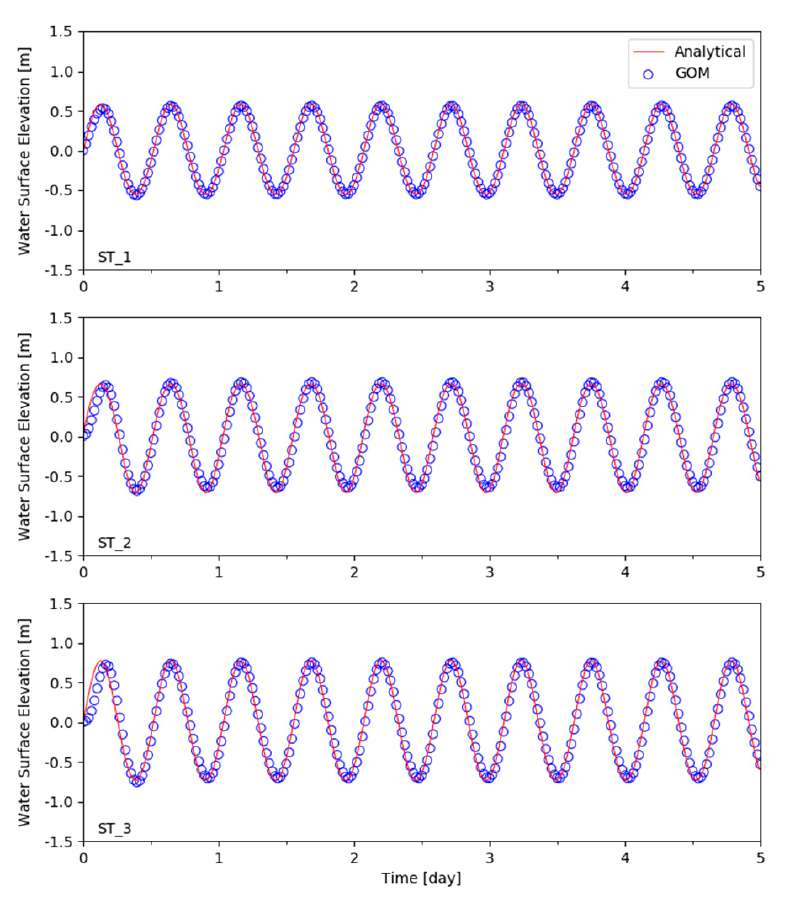
Figure 11. Comparison of water surface elevation for nonlinear advection at three di ff erent locations with θ = 1.0. Solid lines and circles represent analytical solutions and numerical results, respectively. ST_1, ST_2, and ST_3 denote result extraction locations shown in Figure 8. Lynch and Gray [19] derived the analytical solutions for a tidally forced estuary with a flat bottom and a sloping bottom. The quarter-annular test, which contains spatially varying